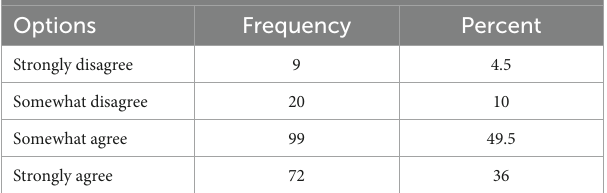
TABLE 2 Participants’ perceptions of the importance of Chinese culture in intercultural communication